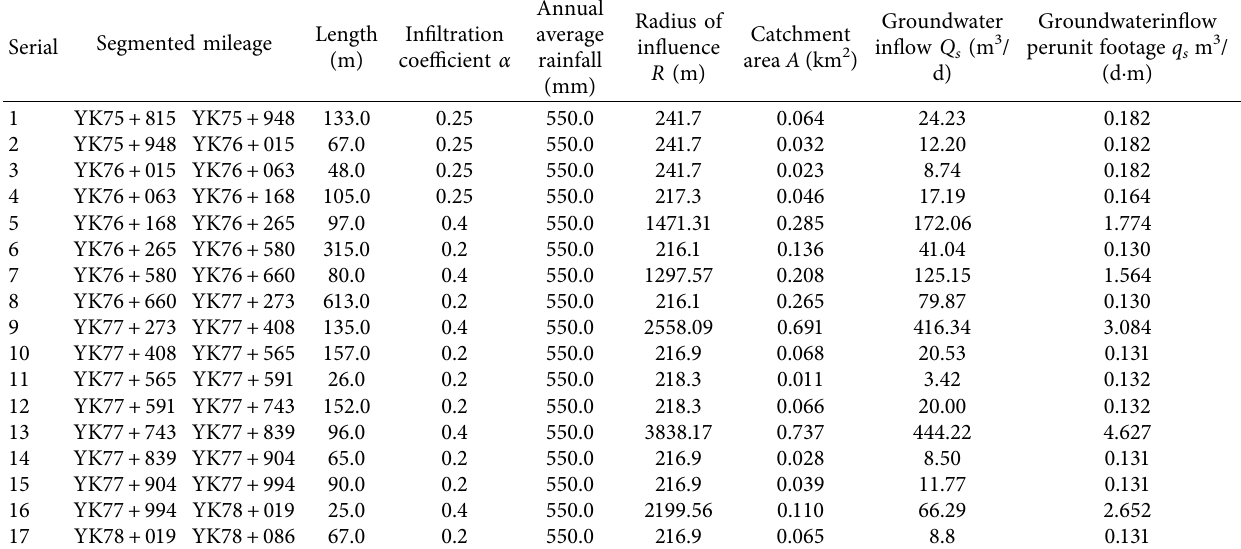
Table 6: Prediction of groundwater inflow into the right tunnel based on the atmospheric precipitation infiltration method. Serial Segmented